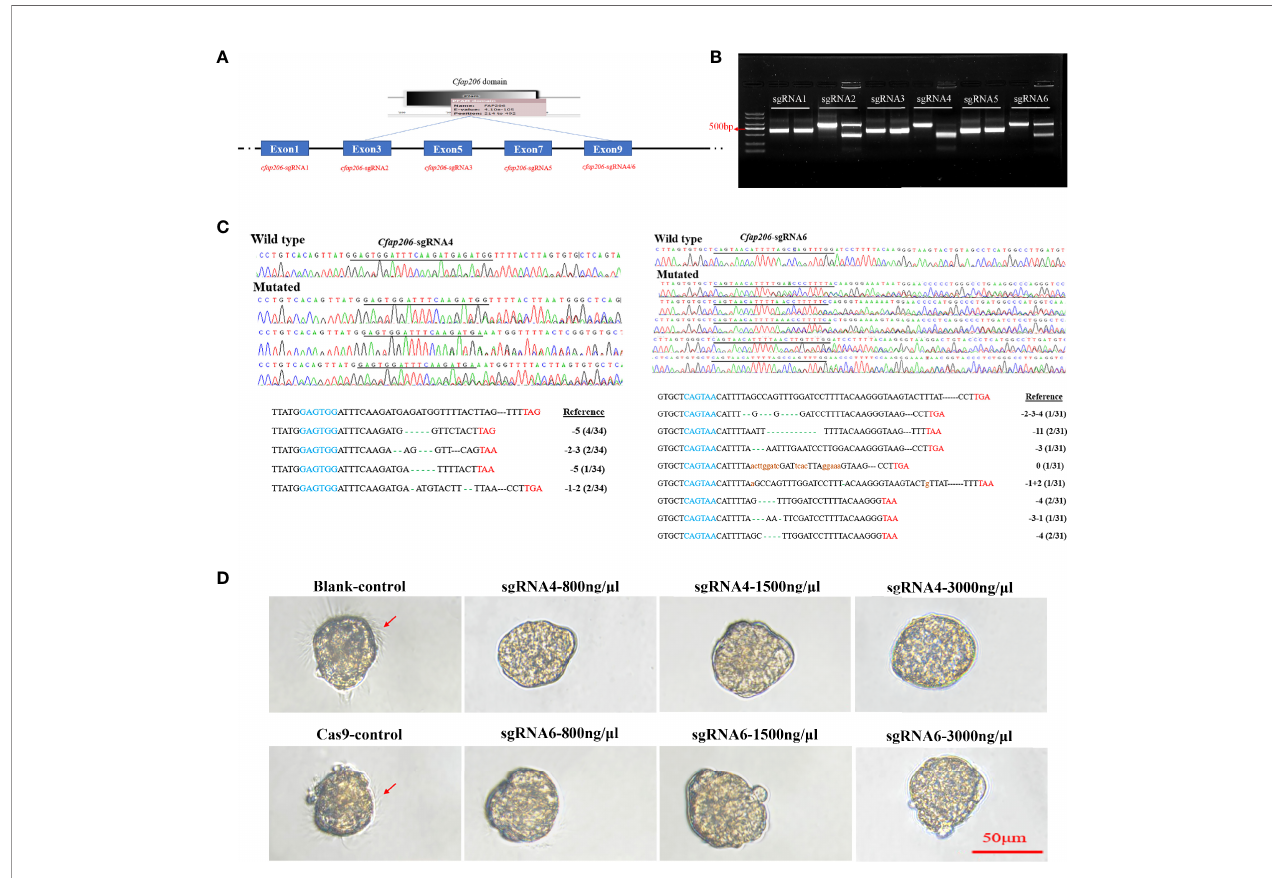
FIGURE 4 | In vitro and in vivo ef fi ciency detection of Cfap206 -sgRNAs. (A) sgRNA screening for MlCfap206 . (B) In vitro cutting ef fi ciency detection of sgRNA1-6. For each sgRNA, the left lane was the control group and the right lane was the experimental group. (C) Sanger sequencing of PCR products from injected embryos and the identi fi cation of mutations. In the left and right bottom panels, the blue sequence marks the start sequence of Cfap206 -sgRNA and the red sequence is the stop codon. (D) Light microscope observation of trochophore larvae after Cfap206